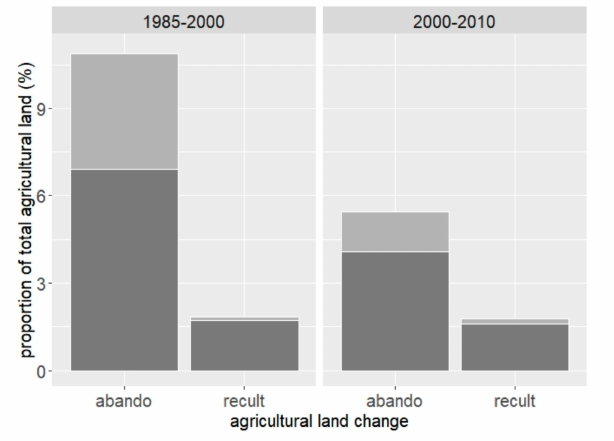
Figure 4. The proportion of agricultural land use in flatland (dark grey color) and mountain regions (light grey color) influenced by abandonment (abando) and recultivation (recult).